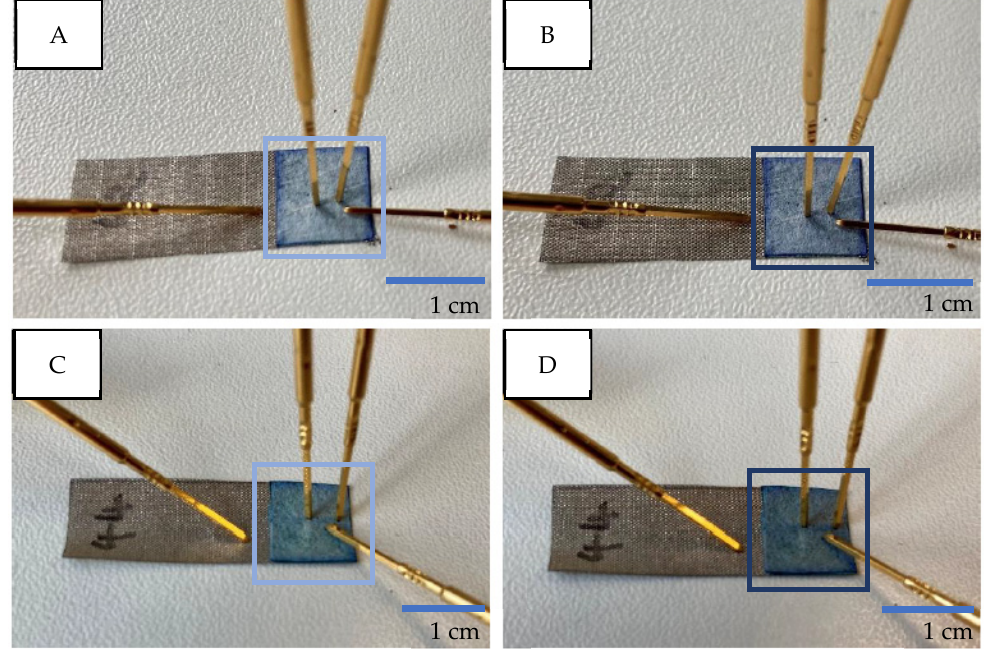
Figure 10. Images of color-changing effect of PEDOT:PSS upon applying different gate voltages (Vg). ( A , C ): − 1.0 V. ( B , D ): +1.0 V.